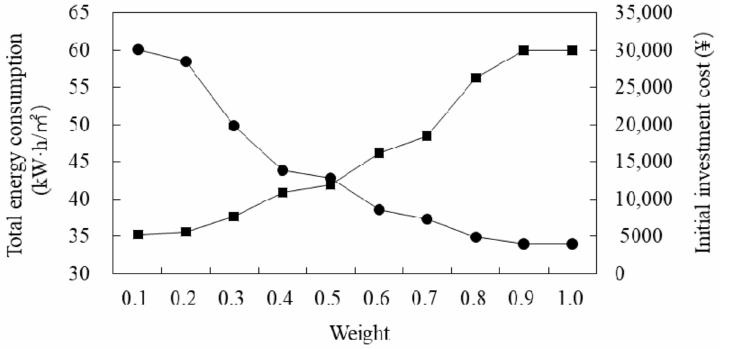
Figure 21. Impact of weight on the optimum values of total energy consumption and initial invest- ment cost.